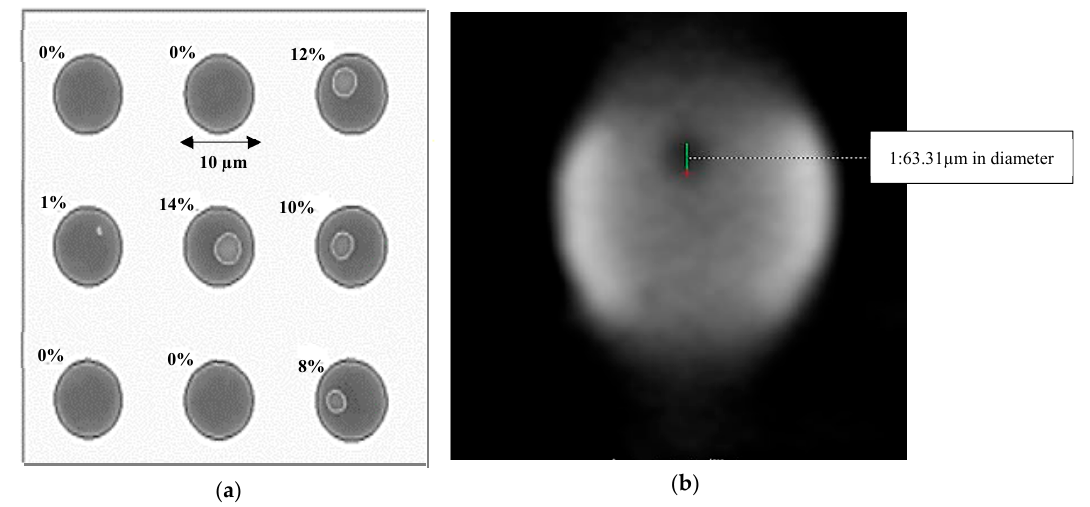
Figure 5. ( a ) Detection of a wafer bump void based on the ratio of the void to the total area [32], ( b ) Void detection in µm level using metallographic microscopic image [36].